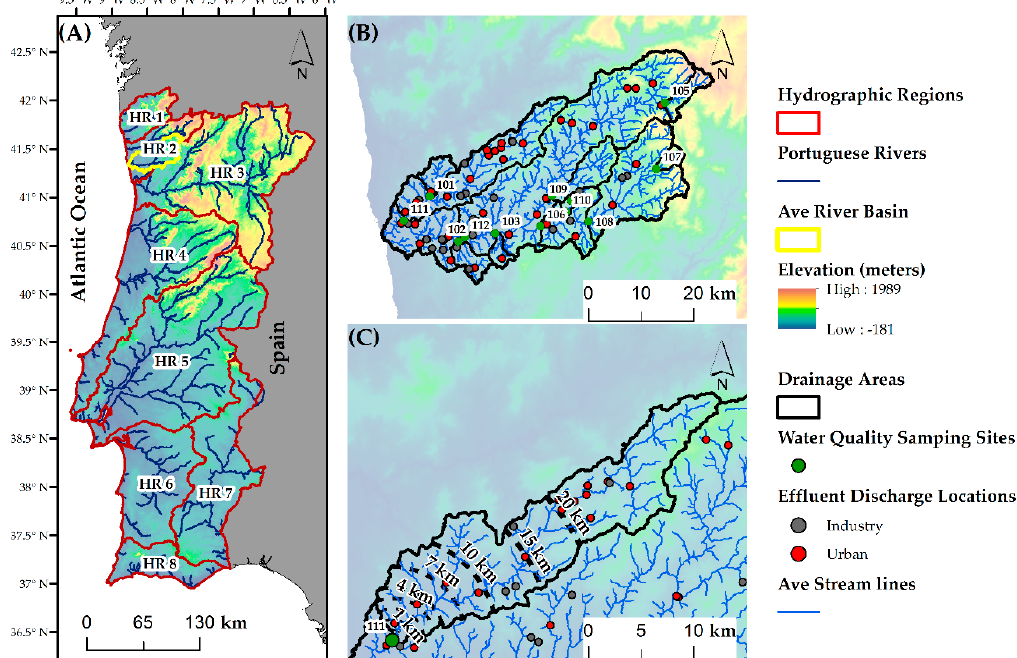
Figure 1. ( A ) Map of Portugal with the distribution of hydrographic regions. ( B ) Ave River Basin and sampling sites. ( C ) Drainage area of sampling site 111 and intersection of buffer limits with the drainage area.